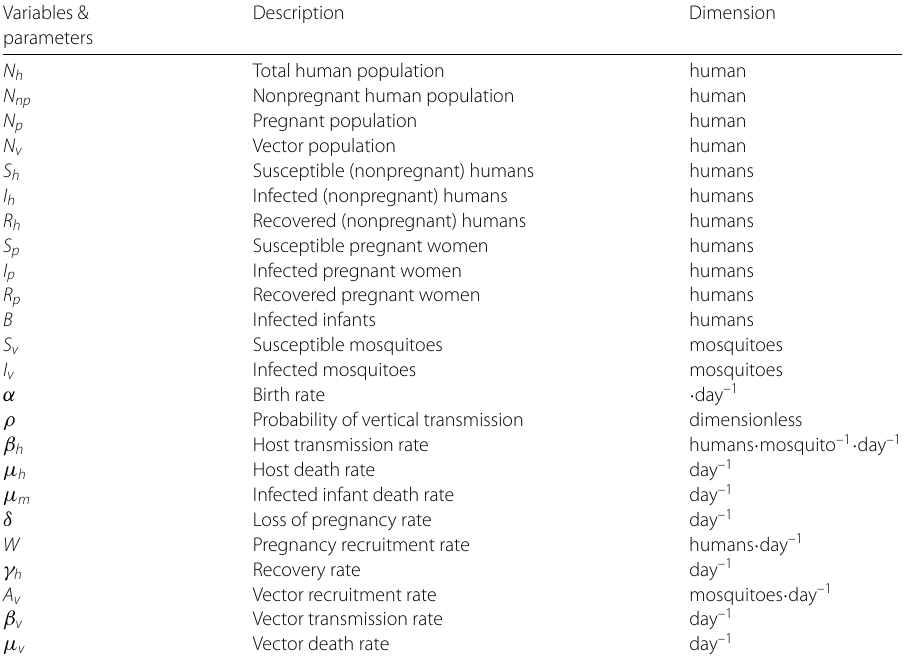
Table 1 Variables and parameters involved in the